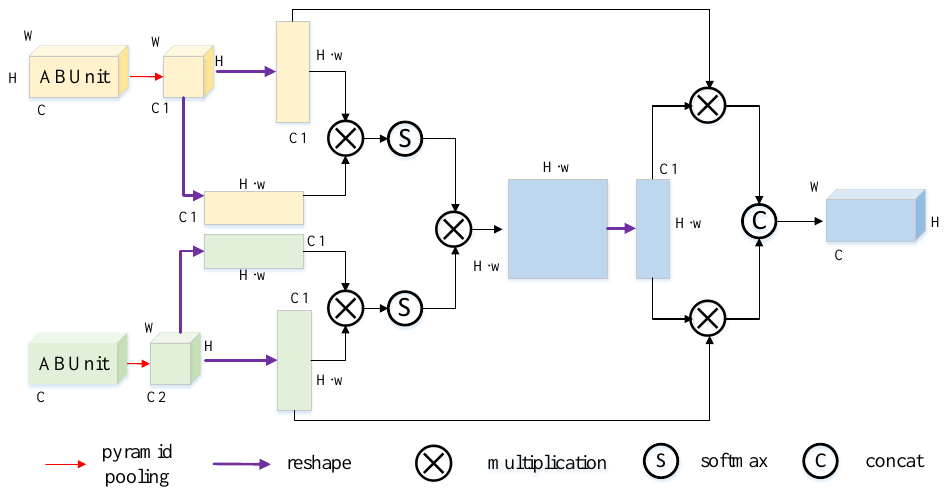
Figure 5. Edge feature attention